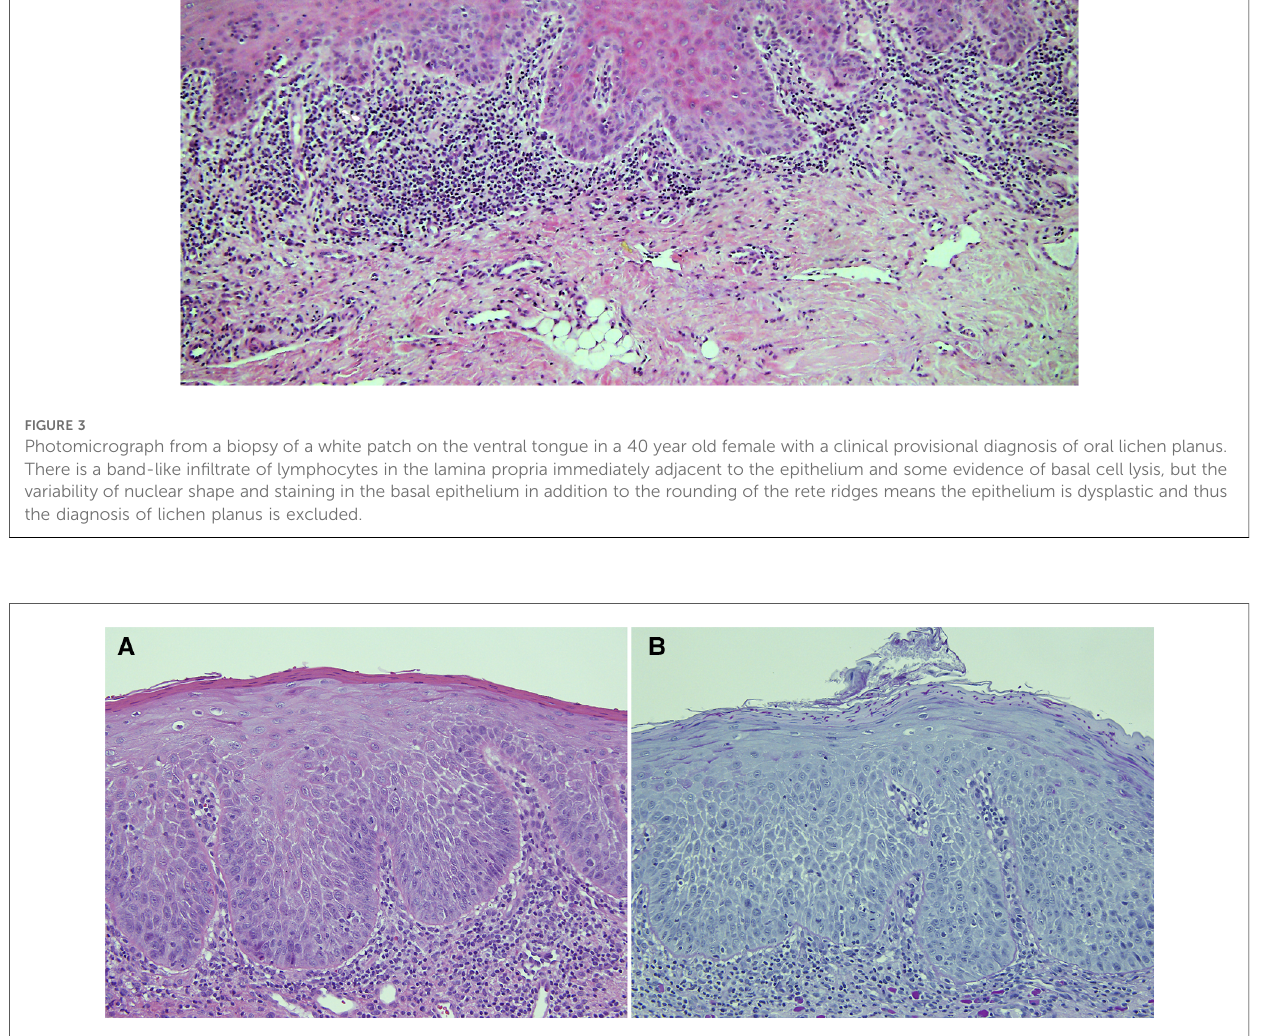
FIGURE 4 This biopsy was from a white patch on the lateral border of the tongue of a 67 year old female with a clinical provisional diagnosis of oral lichen planus. ( A ) (H&E) shows rounded rete ridges and basal cell nuclear size and shape variation with a chronic in fl ammatory cell in fi ltrate in the super fi cial connective tissue. The PAS-stained slide (B) shows numerous candida hyphae and yeast forms in the super fi cial parakeratin. The biopsy diagnosis was epithelial parakeratosis with mild dysplasia with candidal infection. The clinician was advised to re-biopsy the lesion if it persisted after a course of antifungal